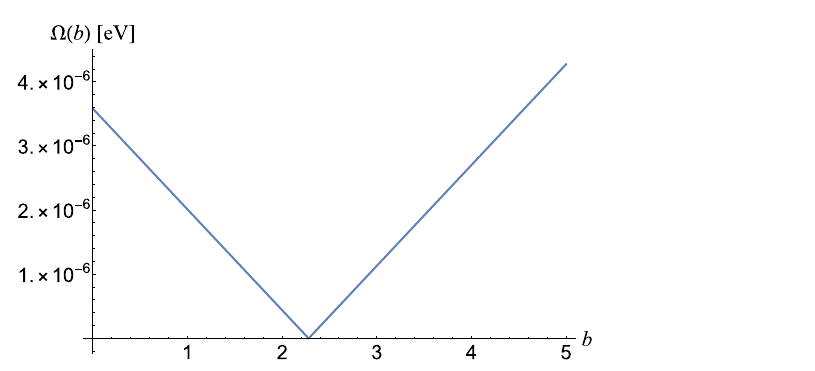
2 p 3 / 2 for the →